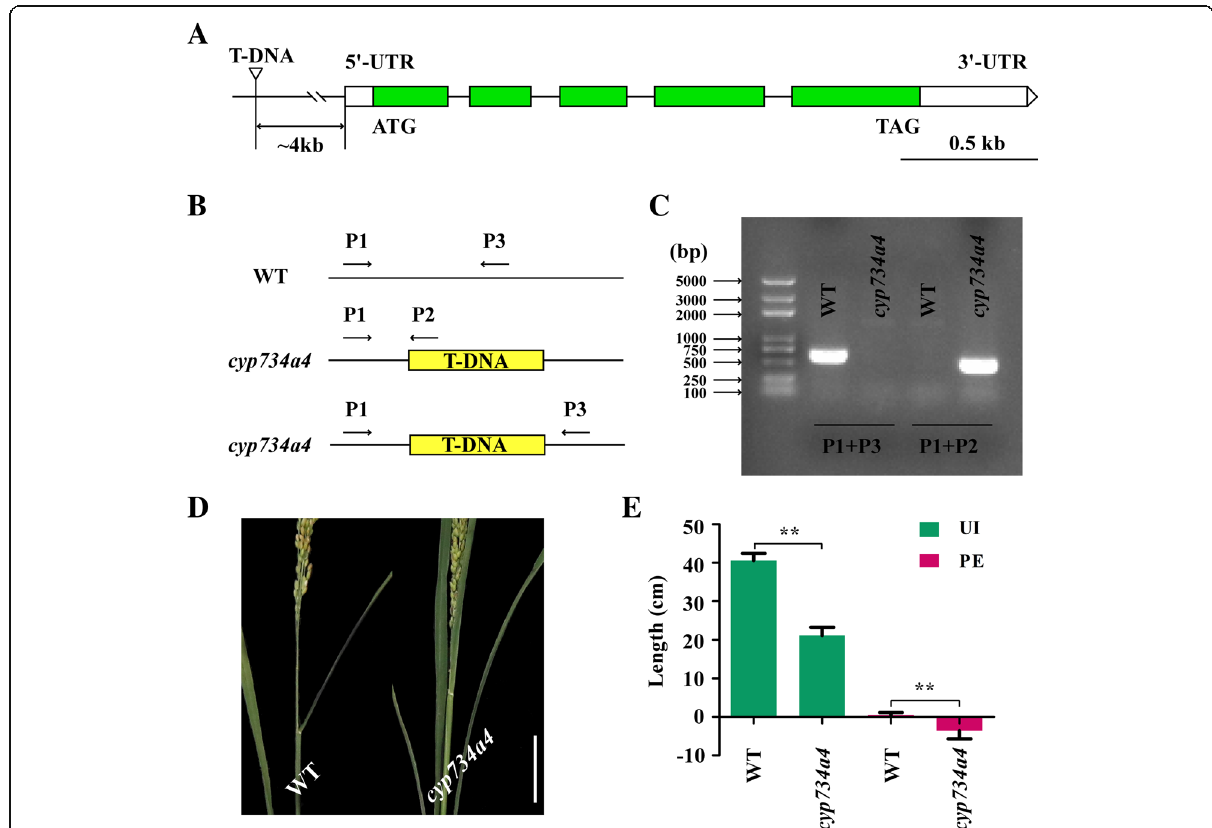
Fig. 5 Identification of CYP734A4 as the causal gene for qPE14 and qUI14. a Schematic presentation of the gene structure of CYP734A4 and T-DNA insertion sites in cyp734a4 mutants. b P1/P2 and P1/P3 are two pairs of primers used to amplify CYP734A4 DNA for PCR analysis. c PCR analysis of WT and cyp734a4 mutants. d , e PE and UI of WT and cyp734a4 mutants. ** indicates a significant difference compared to WT at the 1%